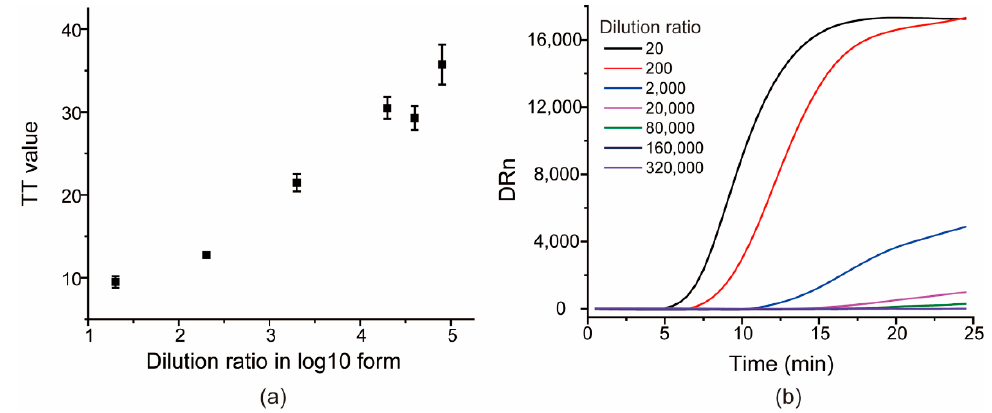
Figure 5. The scatter diagram of TT values versus dilution ratio of SARS-CoV-2 RNA genomes in log10 form ( a ) and the typical amplification curves of the seven templates ( b ).